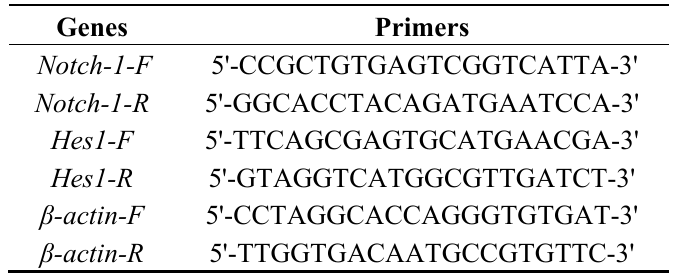
Table 1. Sequence for quantitative real-time PCR